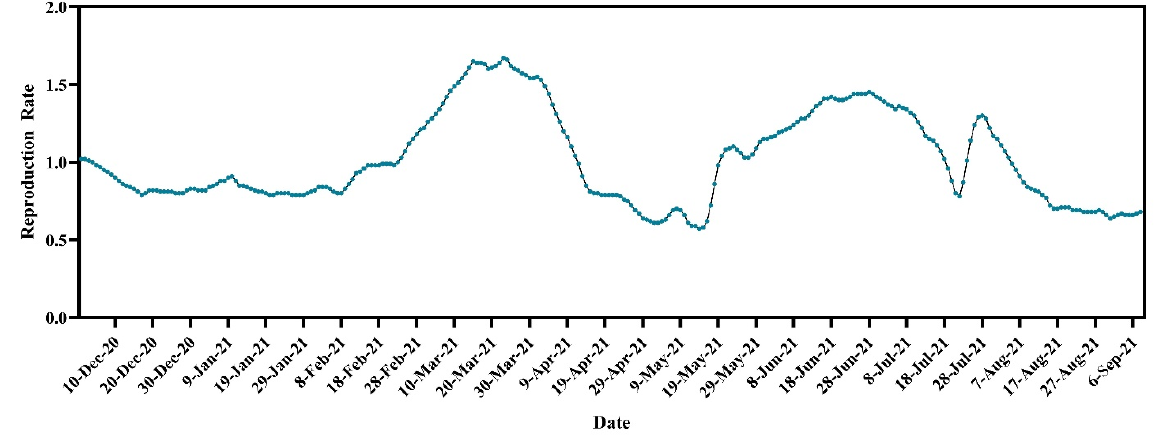
Figure 2. Temporal dynamics of reproduction rate of SARS-CoV-2 cases in Bangladesh (https://ourworldindata.org/coronavirus, accessed on 15 September 2021).